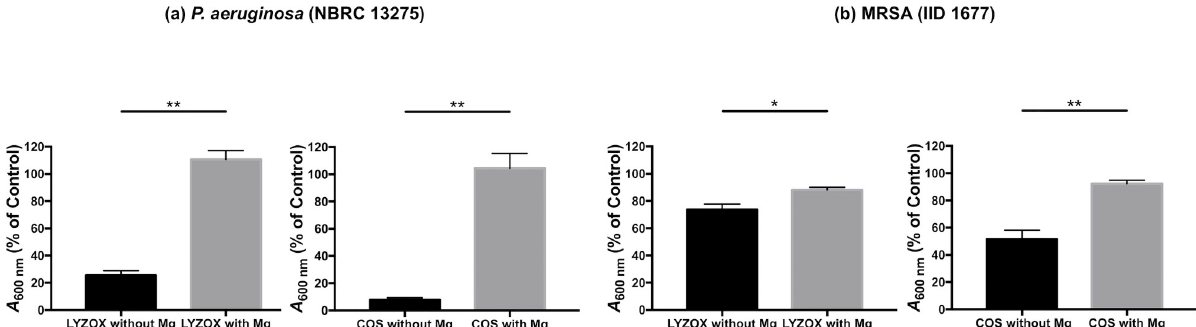
Fig 9. Magnesium effect. (a) Pseudomonas aeruginosa (NBRC 13275), (b) MRSA (IID 1677). Each type of bacteria was incubated with each treatment solution (LYZOX [10,000 μ g/mL] and COS [10,000 μ g/mL]) and magnesium (0.05 M) in tryptic soy broth (TSB) at 37 ˚C for 10 h. Then, each solution was measured spectrometrically at 600 nm ( A 600 nm ) and compared with the value of the control. The control was TSB without each treatment. In order to evaluate the effect of magnesium, we performed the same experiments without magnesium. The values are the mean ± SEM from three independent experiments for P . aeruginosa (NBRC 13275) and MRSA. � p < 0.05, �� p < 0.01 (unpaired t-test). LYZOX: lysozyme-chitosan oligosaccharide conjugate. COS: chitosan oligosaccharide. Mg: